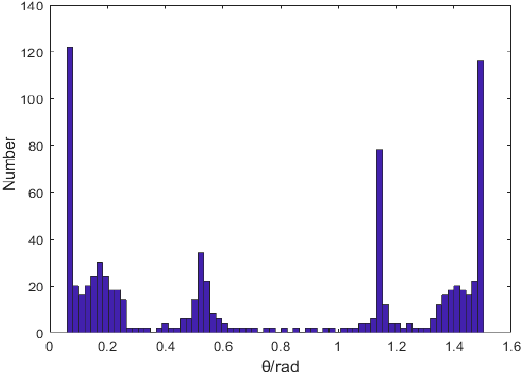
Figure 3. The statistical histogram of angular distribution.